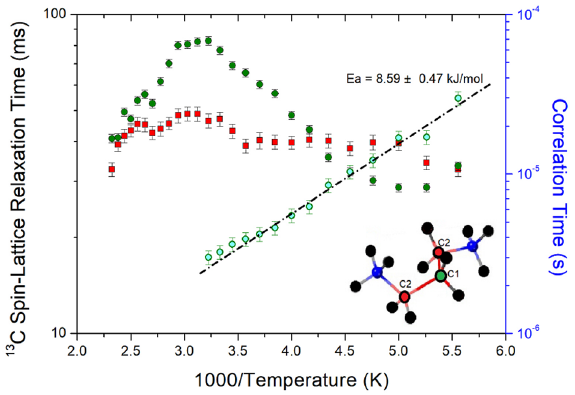
Figure 7. 13 C NMR spin–lattice relaxation times T 1ρ and correlation times for C1 and C2 of [NH 3 (CH 2 ) 3 NH 3 ] CuBr 4 as a function of inverse temperature.